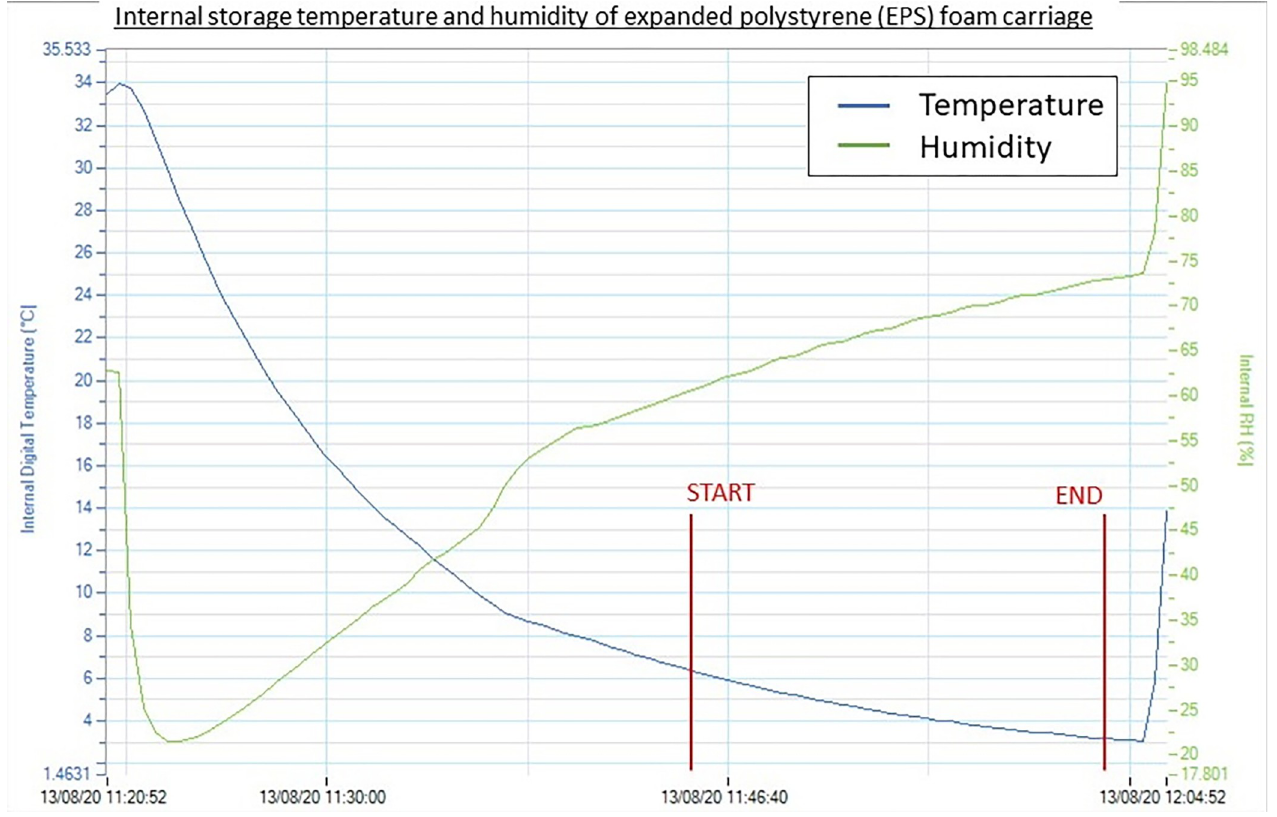
Fig 4. Datalogger result of Flight 3. Result in Flight 3 which used expanded polystyrene (EPS) foam drone carriage material showed the lowest and most stable result of mean kinetic temperature ± SD of 4.70 ± 1.14˚C.